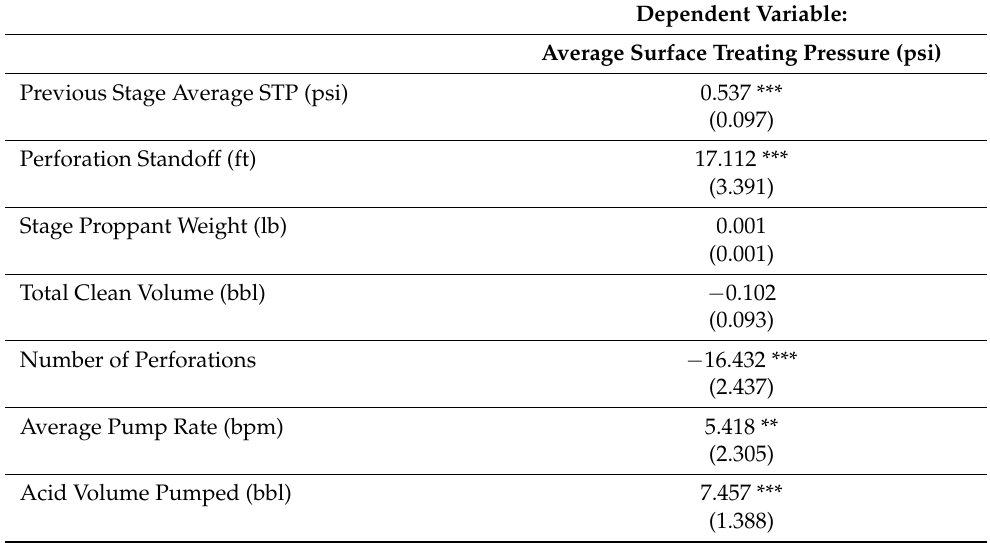
Table 5. Results from the dynamic FE model with clustered se using the stargazer package from R